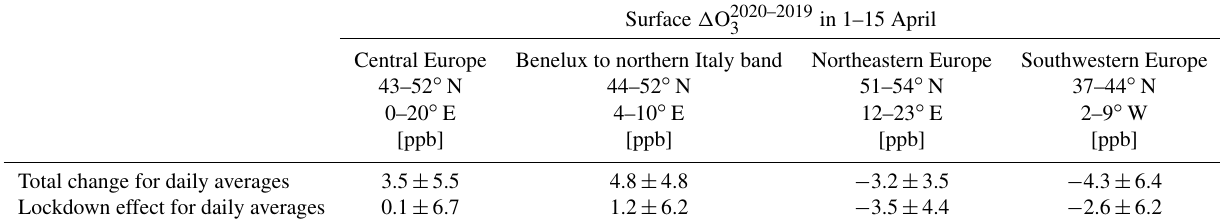
Figure 6. Surface NO 2 concentrations (ppb) averaged over the period 1–15 April 2019 (a) simulated by the CHIMERE and (b) measured by in situ sensors. Panels (c) and (d) are the same as panels (a) and (b) , respectively, but for changes between 1–15 April 2020 with respect to the same period in 2019. Table 4. Changes of daily averages of surface ozone concentrations between 1–15 April 2020 and the same period in 2019, for four target regions in Europe (rectangles in Fig. 3a), derived from surface in situ measurements. Total, meteorological, and lockdown-associated changes are considered in mixing ratio units (ppb). Values after ± indicate 1 standard